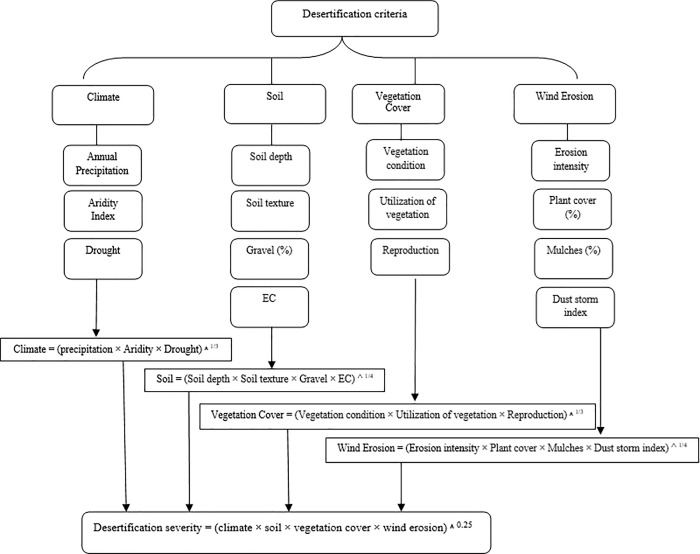
Flowchart and different steps of determining the intensity of desertification based on IMDPA model in each working unit.